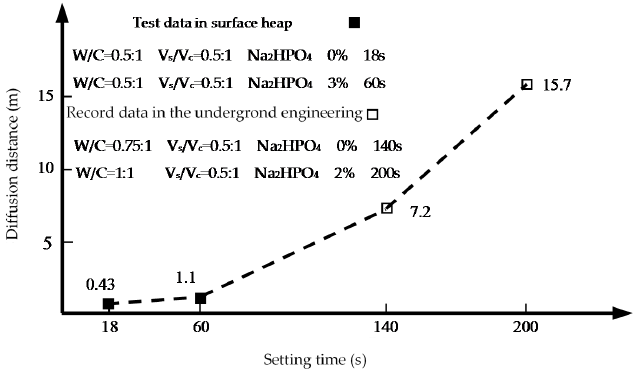
Figure 7. Relationship of setting time–vertical diffusion distance of C–S grout in the loose rock mass. W/C: water cement ratio; Vs/Vc: volume ratio of sodium silicate to cement slurry.